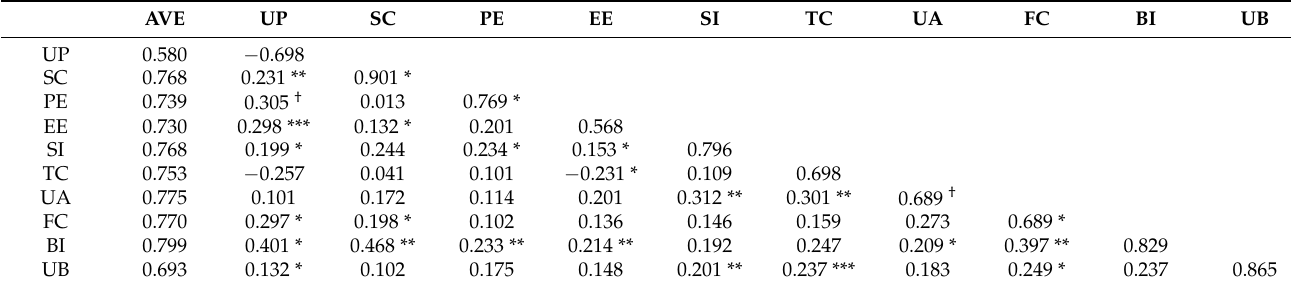
Table 5. Discriminant validity assessment.